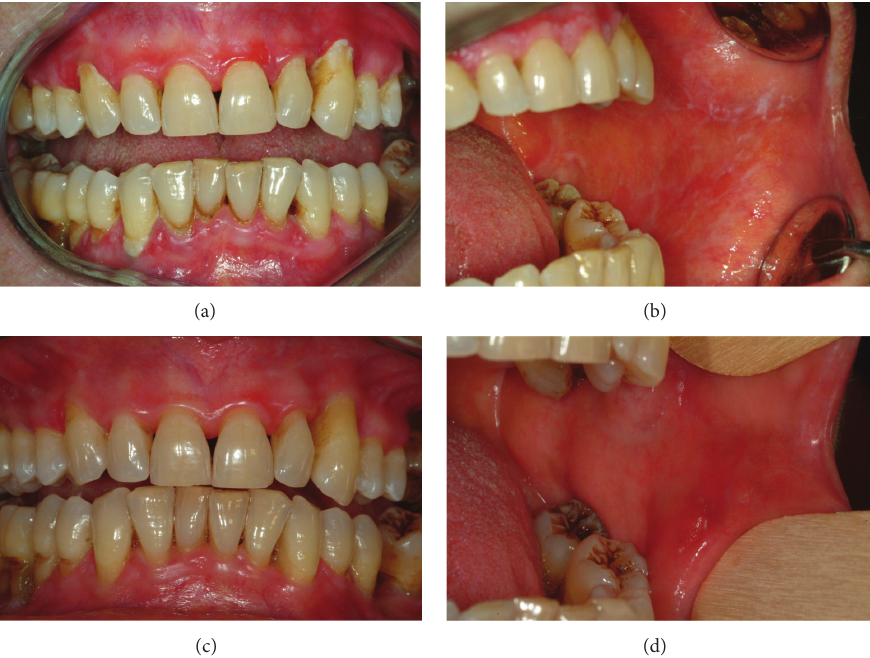
Figure 1: Sixty-three-year-old female patient with gingival and buccal cGVHD at baseline ((a), (b)), and after the proposed protocol ((c),